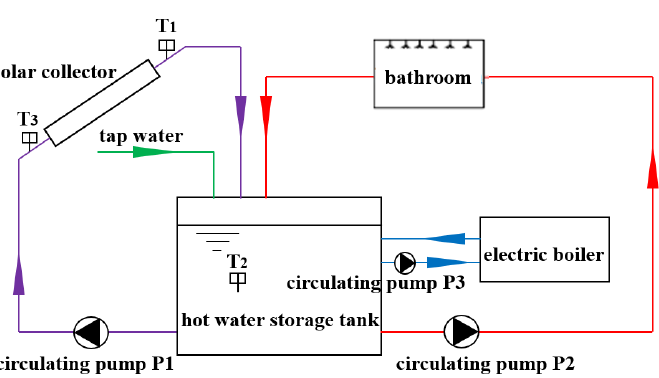
Figure 1. Schematic diagram of the original solar-assisted electric boiler water heating system.